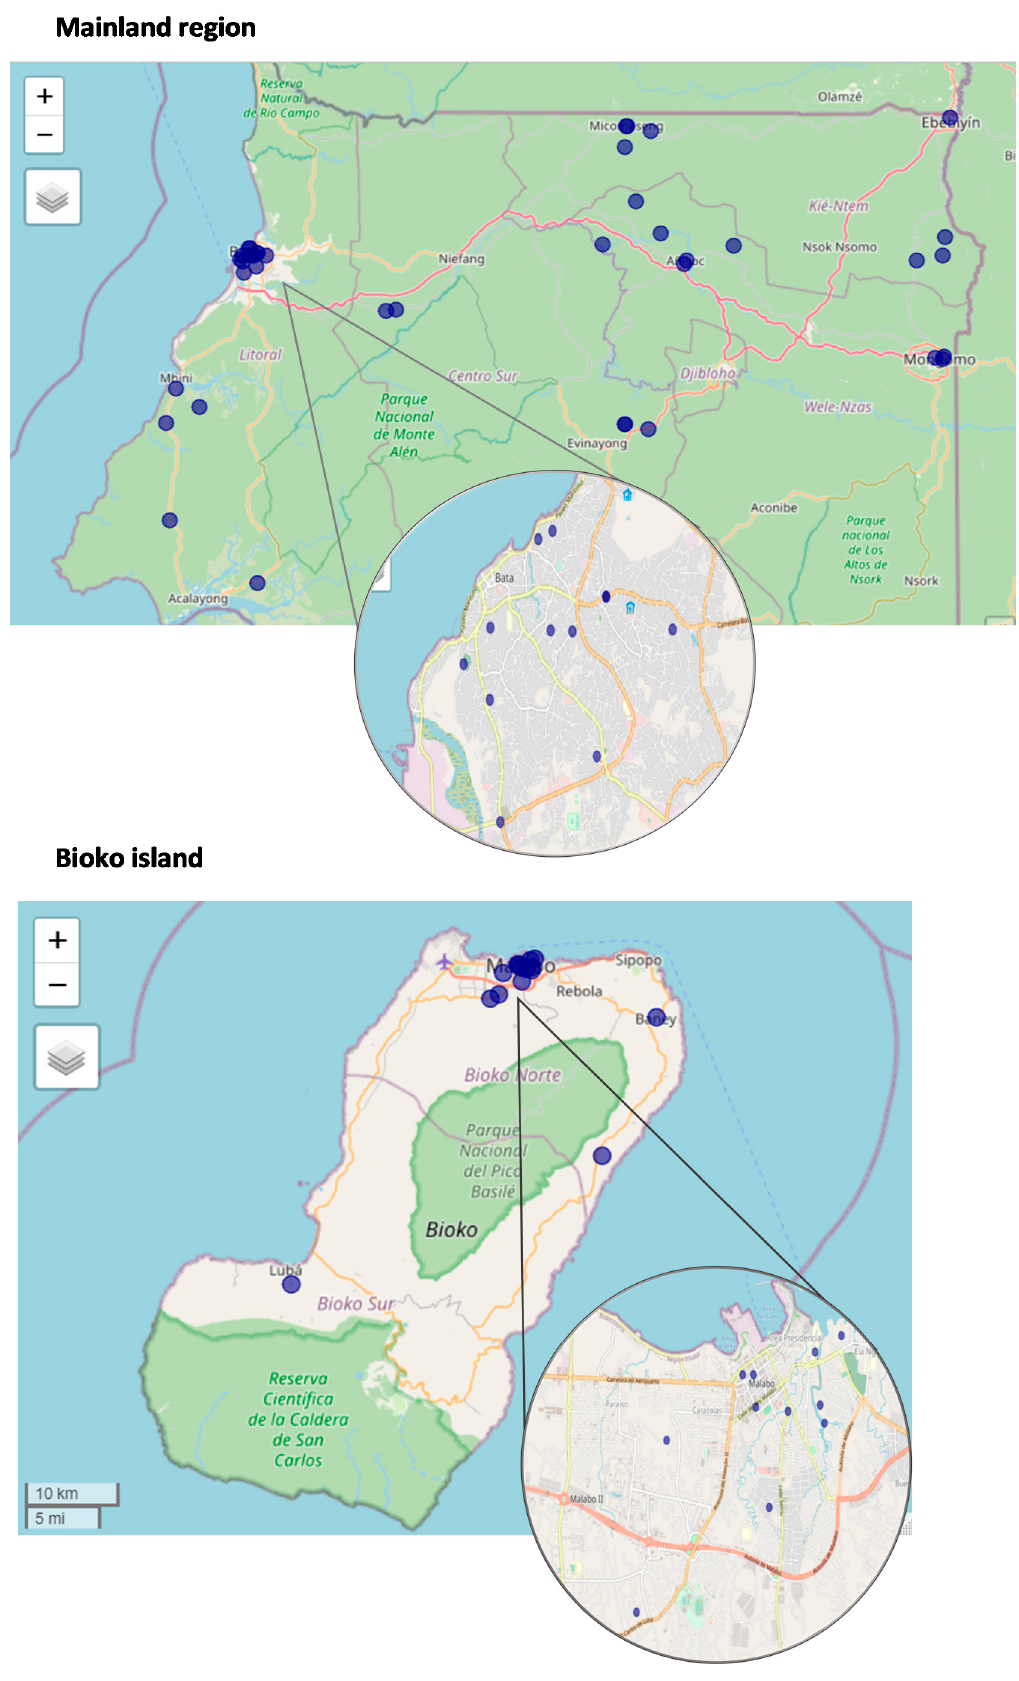
Figure 1. Communities of Equatorial Guinea where the interviews were carried out.